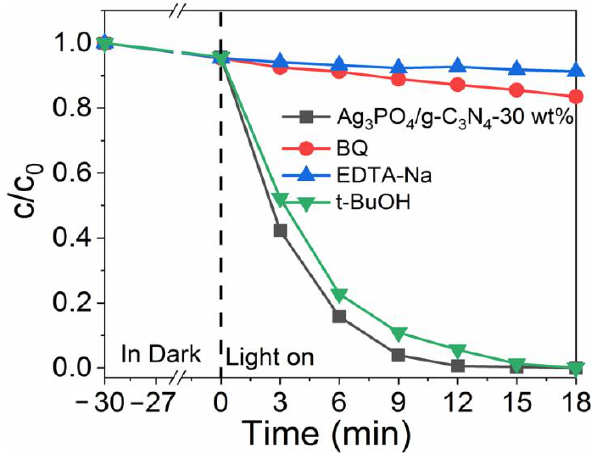
Figure 7. Photocatalytic activities of Ag 3 PO 4 /g-C 3 N 4 -30wt% for the degradation of Rh B in the presence of different scavengers.